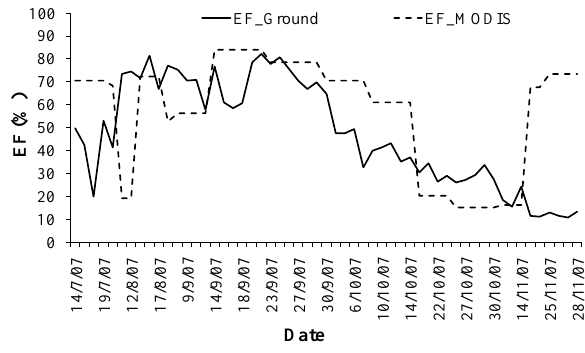
Fig. 10 Fig. 7 . Samples of daily patterns of 30-min net radiation during the period Sep. 7-27, Fig. 7. Samples of daily patterns of 30-min net radiation during the period 7–27 September 2007 at the SD-Dem site. 2007 at the SD-Dem site. Fig. 9 . Time series of EF estimated from MODIS data and calculated from eddy Fig. 9. Time series of EF estimated from MODIS data and calcu- lated from eddy covariance flux data at the SD-Dem site in 2007. covariance flux data at the SD-Dem site in 2007.